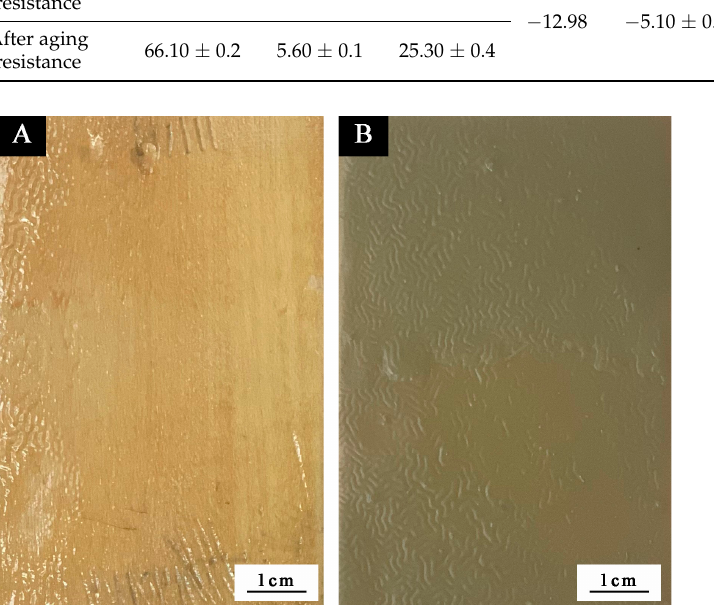
Figure 7. Coating image (sample C): ( A ) before aging resistance and ( B ) after aging resistance.